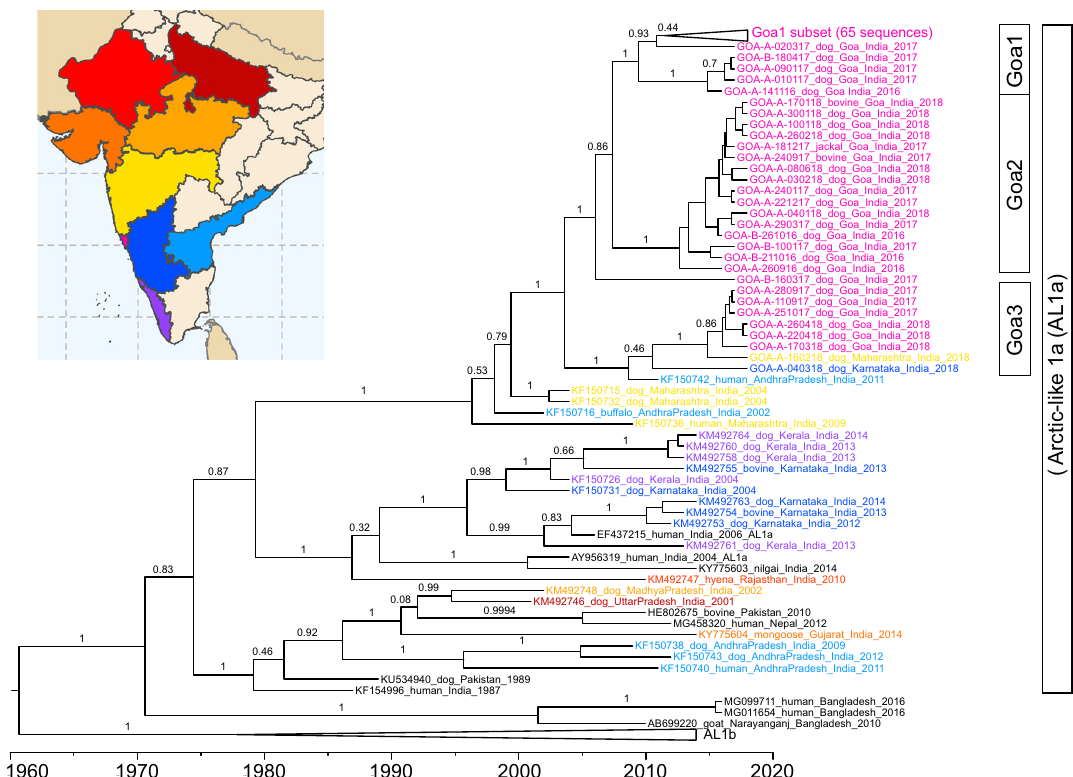
Fig. 6 Time-scaled phylogeny for Goa samples and reference samples from other states of India. Time-scaled phylogeny of partial glycoprotein gene sequences (1317 nt) of Goa samples, Karnataka samples, and Maharashtra samples generated in this study with representative reference sequences from India belonging to the Arctic-like 1a rabies virus lineage. Representative samples from the Arctic-like 1b lineages were included as an outgroup. Scale at the bottom indicates year. Sample IDs are colored based on the state of sample collection, according to the coloration on the map. Bars to the right indicate members of Goa1, Goa2, and Goa3 groups. Numbers at the branches indicate posterior support values. AL1b: Arctic-like